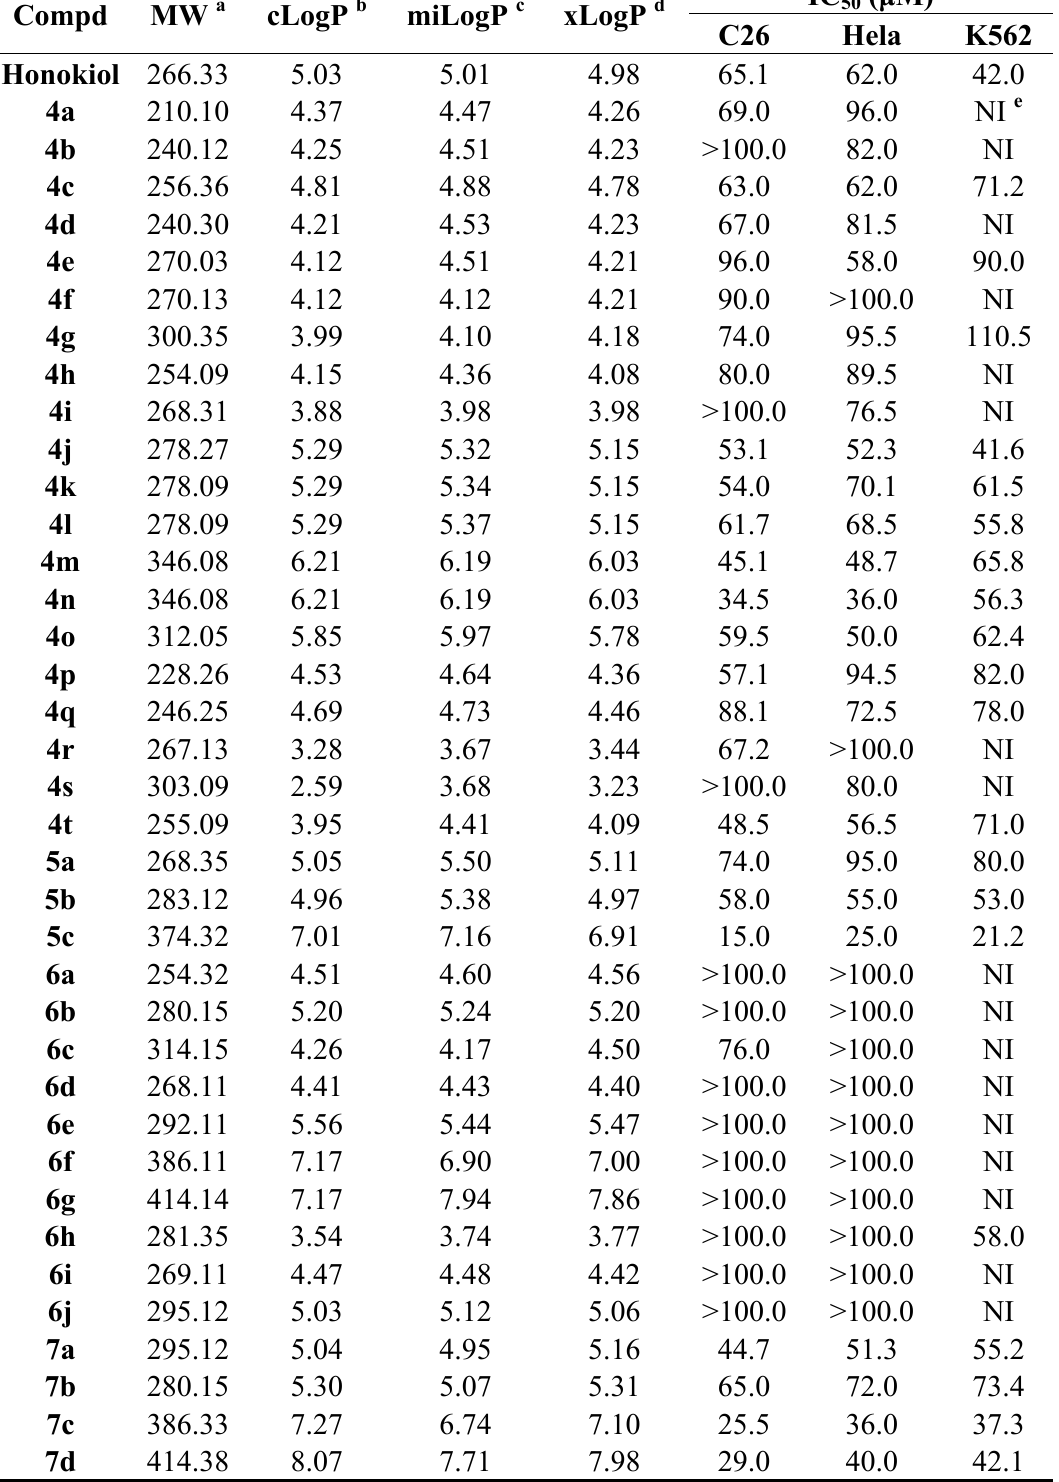
Table 1. IC values against C26 and Hela cells and calculated properties of allylated 50